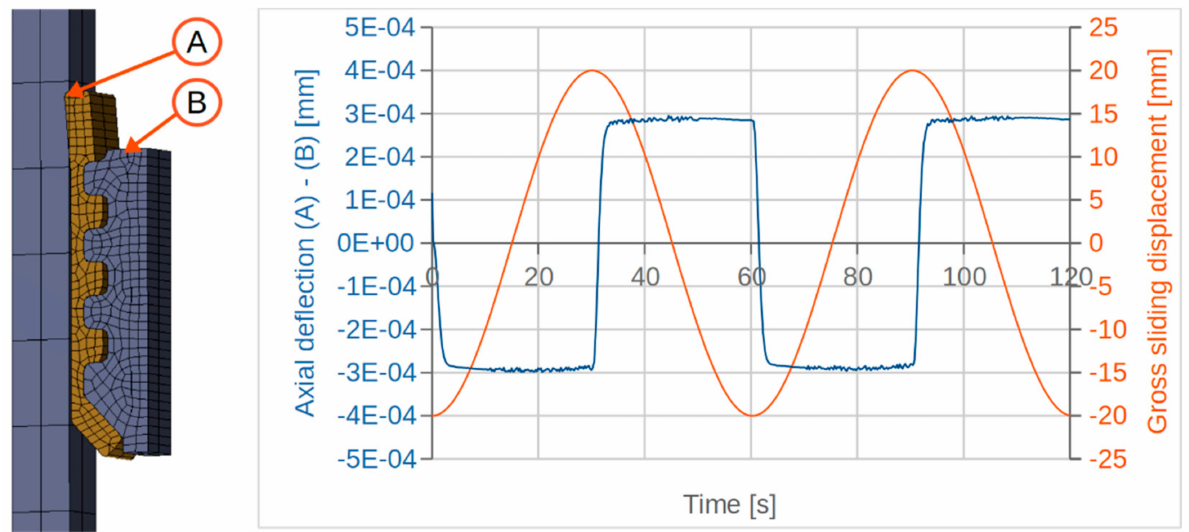
Figure 11. Left panel: FEM model of the piston/tube friction point including the end lip of the piston band ( A ) and the displacement application face of the piston ( B ). Right panel: comparison of the displacement boundary condition applied to the piston (orange) and the distance between ( A ) and ( B ) (blue) during the friction recording